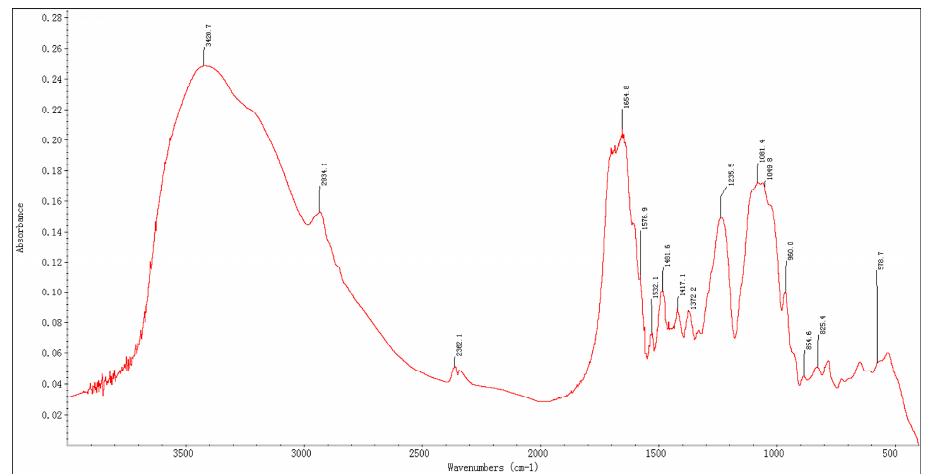
Figure 2. FT-IR spectrum of B. exarata polysaccharide-protein complex BEPS-IA.